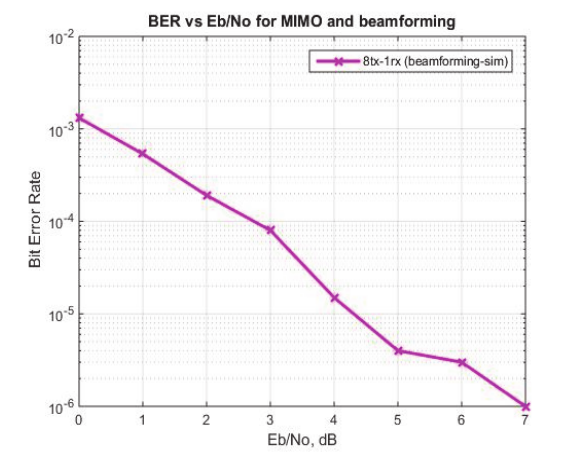
Fig. 4. BER vs E b / N o for 8 × 1 BF detection.